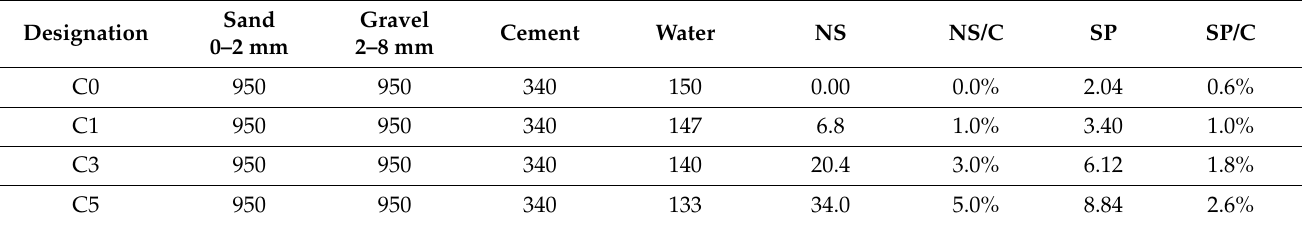
Table 4. Mix compositions of concrete [kg/m 3